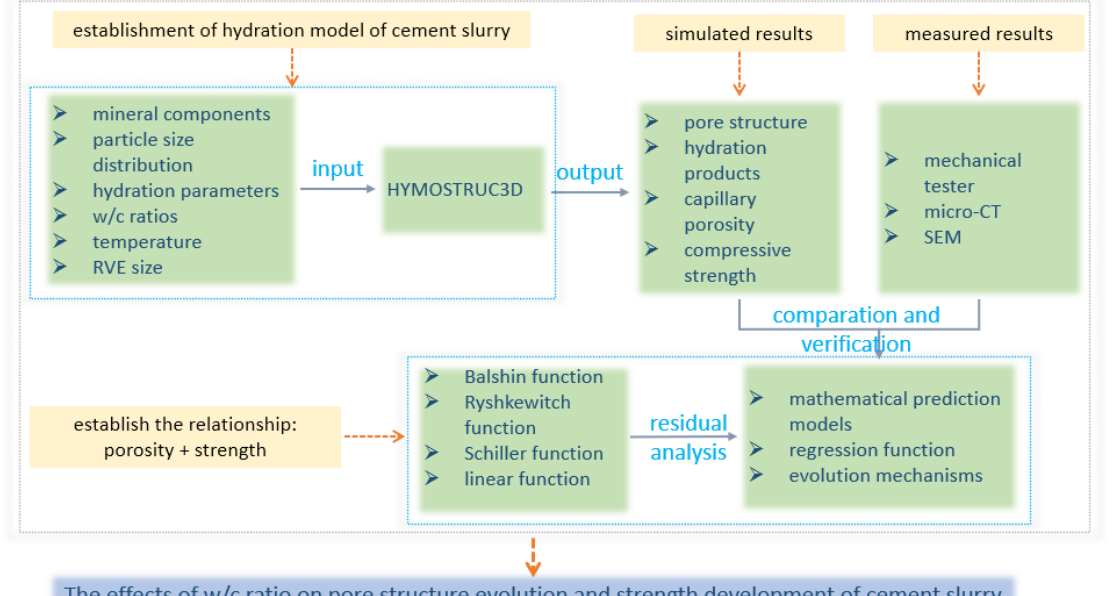
Figure 1. The flowchart of the research approach.